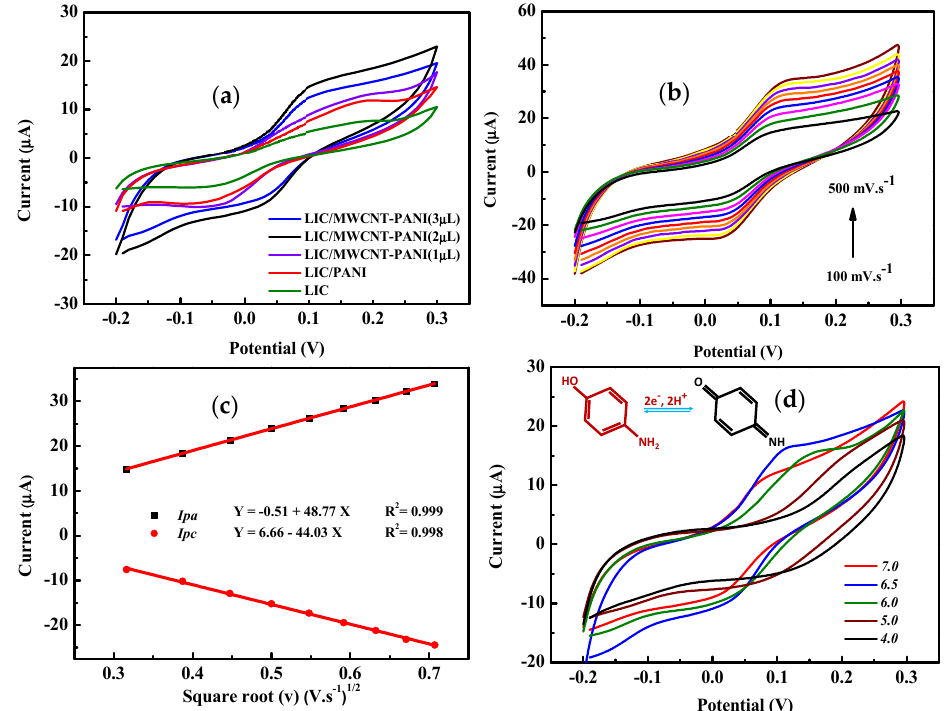
Figure 7. ( a ) CVs obtained by bare LIC, LIC/PANI and LIC/MWCNT-PANI in the presence of 1.0 mM 4-AP in 0.1 M PBS (pH = 6.5) Scan rate of 100 mV·s − 1 , ( b ) LIC/MWCNT-PANI in the presence of 1.0 mM 4-AP in 0.1 M PBS (pH = 6.5) at different scan rates from 100 mV·s − 1 to 500 mV·s − 1 ; ( c ) Linear fitting of the peak current with the square root of scan rate. Inset oxidation current against the scan rate (100 to 500 mV·s − 1 ); ( d ) CVs LIC/MWCNT-PANI response of 1 mM 4-AP in 0.1 M PBS in different at 100 mV·s − 1 scan rate and the inset: Redox reaction mechanism of 4-AP.